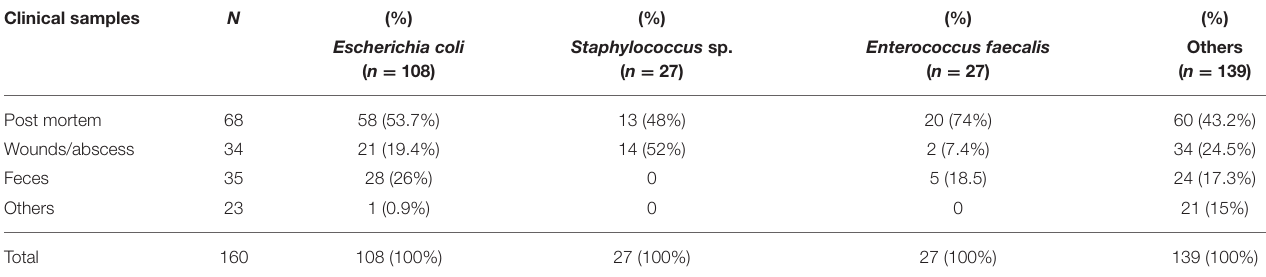
TABLE 2 | Species of bacteria isolated from samples from diseased non-ruminants received by the Bacteriology Laboratory between 2015 and 2017. Clinical samples